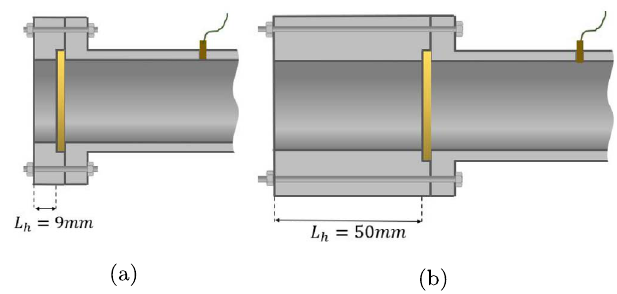
Figure 2. Impedance tube termination with a) short sample holder of length L h = 9 mm and b) long sample holder of length L h = 50